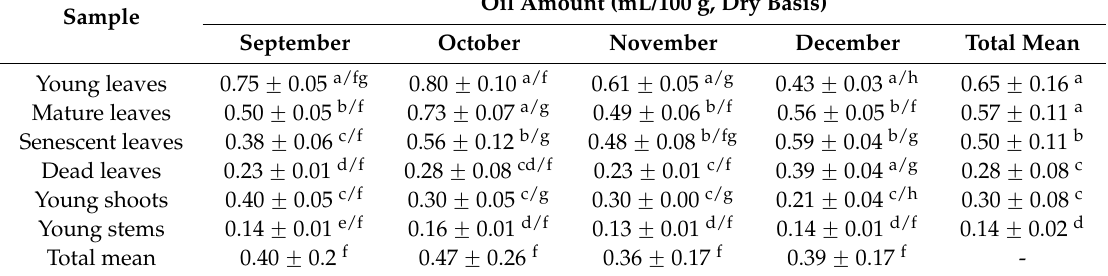
Table 1. Yields (mL/100 g) of essential oils from different plant organs of B. balsamifera at different growth